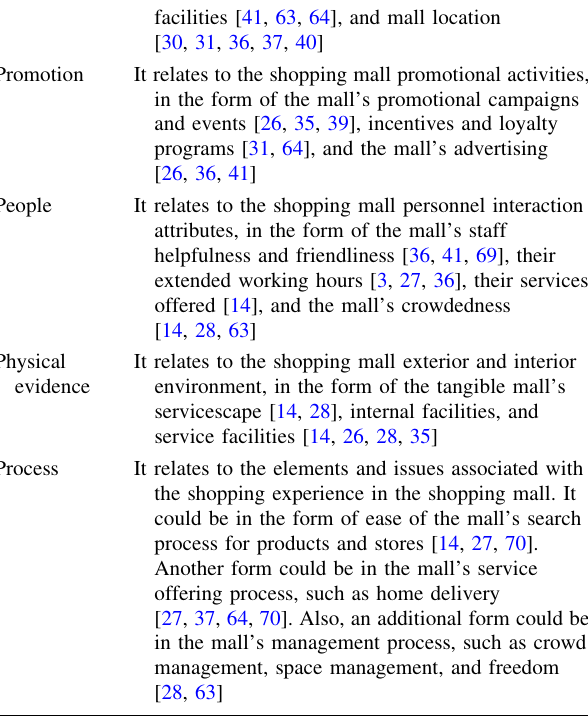
Fig. 7 Indicative weight percentages of the above themes from the study-reviewed